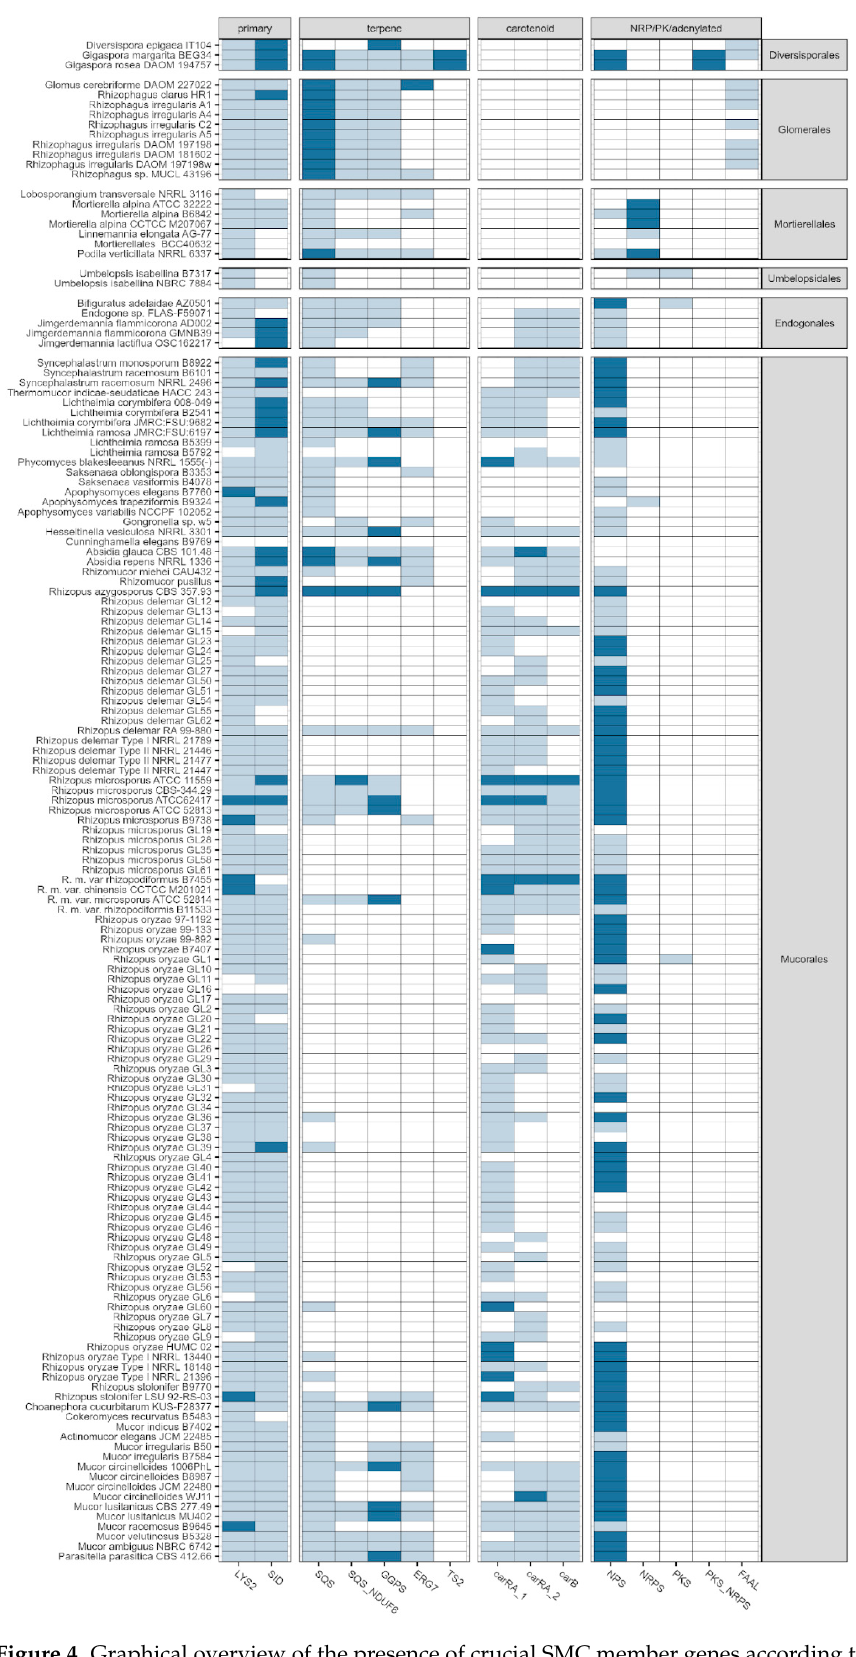
Figure 4. Graphical overview of the presence of crucial SMC member genes according to the results of candidate gene family annotation. Nine isolates lacking any detected SMCs, as well as GFF annotation, were left out (seven Glomeromycota , two Cunninghamella bertholletae ). Gene families: